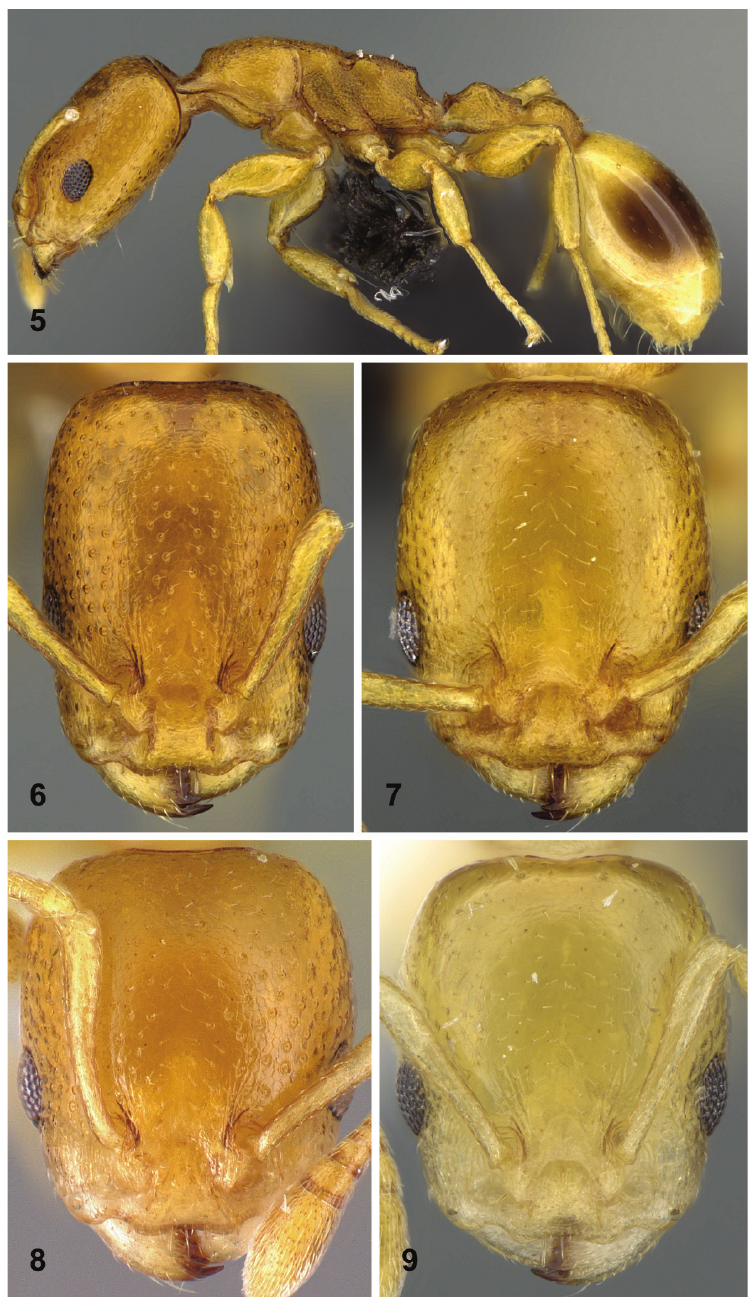
Figures 5–9. Diagnostic traits for yellow Nesomyrmex brevicornis -group workers. Lateral view of meso- soma, petiole, postpetiole and gaster of N. cingulatus sp. n. ( 5 ), frontal view of head of N. cingulatus sp. n. ( 6 ), frontal view of head of N. minutus sp. n. ( 7 ), frontal view of head of N. punctaticeps sp. n. ( 8 ), frontal view of head of N. sellaris sp. n. ( 9 ). For details see main